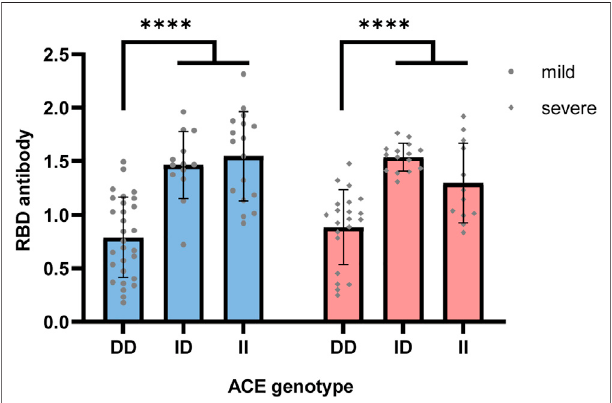
FIGURE 3 | RBD antibody concentration in COVID-19 patients with differentACEgenotypes.Genotype-speci fi cRBDantibodyconcentrationwas tested with an ELISA kit, which can detect the antibody targeting on the RBD of the ACE2 receptor in the serum sample. Sample with I alleles had the highest concentration of the RBD antibody in both mild and severe disease conditions (II mild (cid:1) 1.55, ID mild (cid:1) 1.46; DD mild (cid:1) 0.79, one-way ANOVA,